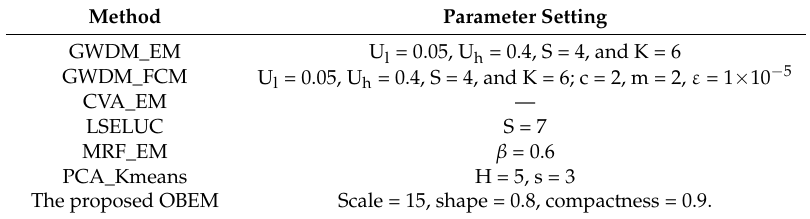
Table 1. Parameter settings of different land cover change detection (LCCD) methods for the first and second data sets.